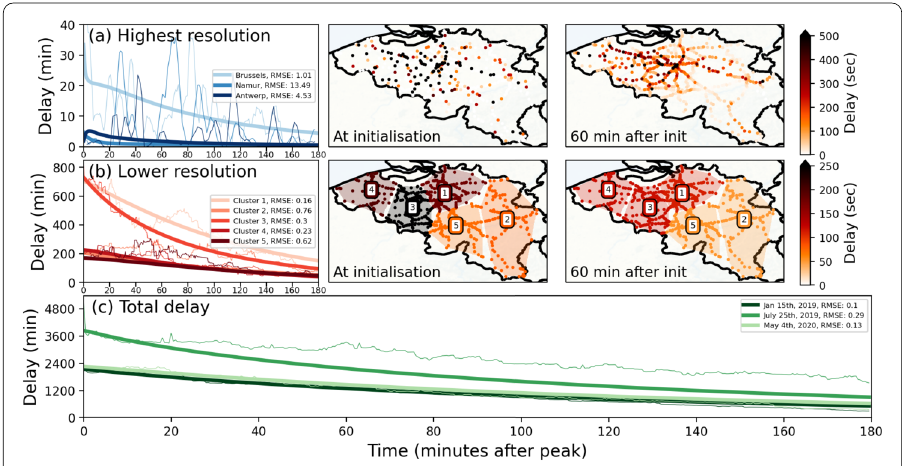
Figure 4 Example simulations at various resolutions. Panel ( a ): highest (non-clustered) resolution simulation of Jan 15th, 2019, initialised at the peak delay (18:11). The delay evolution over time of three example stations is displayed in blue lines (Brussels, Namur and Antwerp). The spatial situation of simulated delays at initialisation (middle) and 60 min after initialisation (right) are also shown. Panel ( b ): Simulation of the same day, but at an spatially aggregated level of five clusters. Red lines in the left panel show the temporal evolution of delays for each cluster. Again, the middle and right panels indicate spatial delay distribution at initialisation and 60 min after initialisation. For clarity, the clusters are shaded in the background. Panel ( c ): Total delay evolution of three example bad days: Jan 15th, 2019, July 25th, 2019 and May 4th 2020, all initialised at their peak delay moments. All maps show delays in seconds, with a cut-off at 500 and 250 seconds respectively, as higher delays were rare on these instances. Root mean square errors of each of the (normalized) time series are shown in the